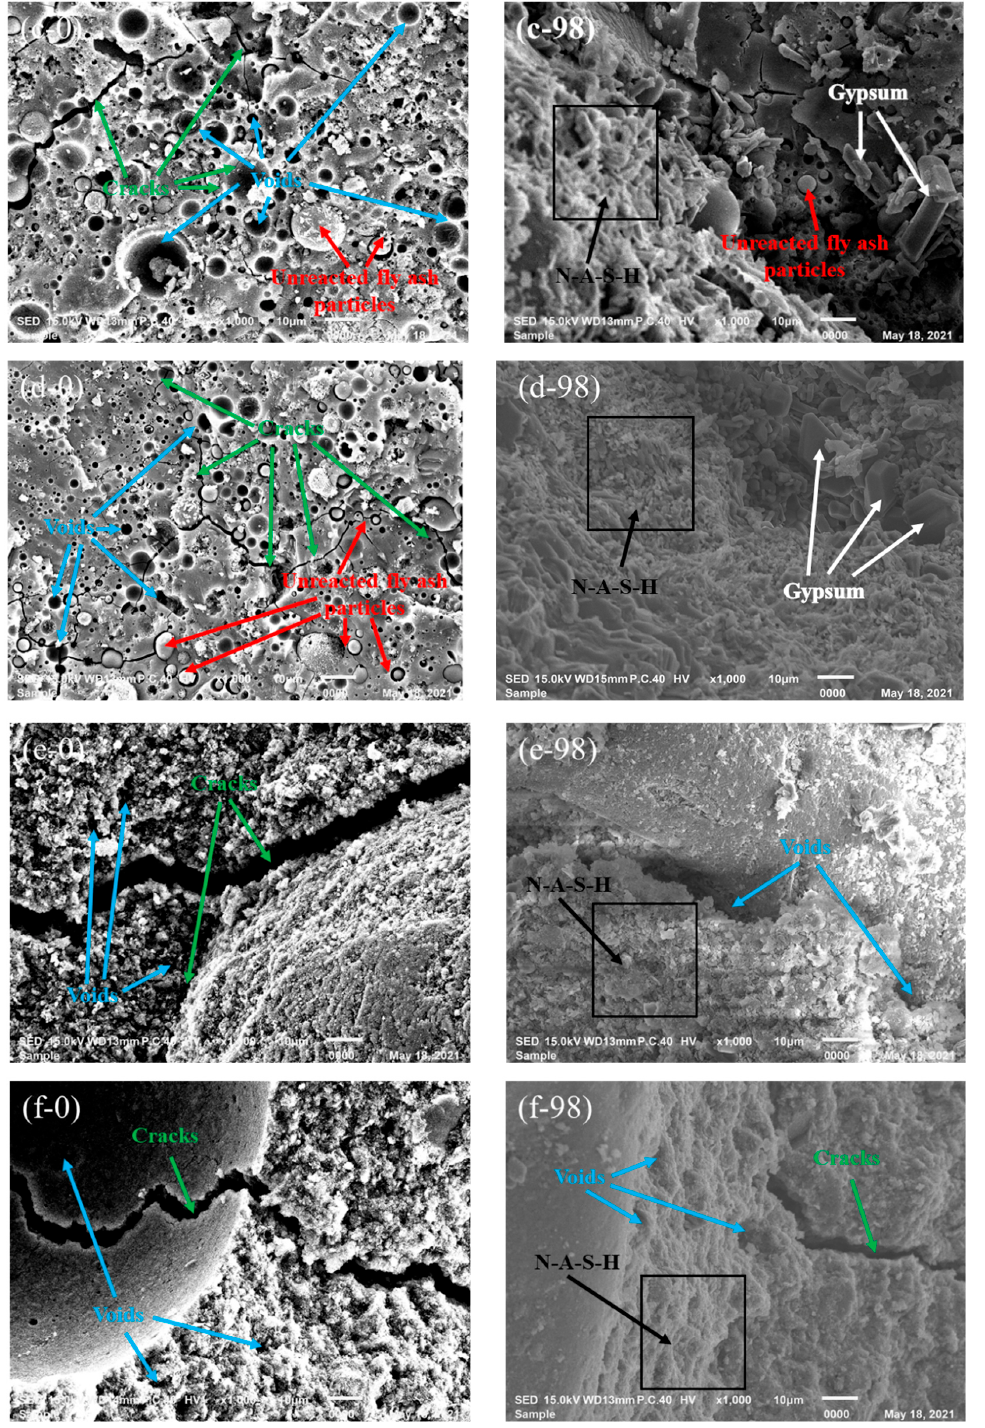
Figure 7. SEM images of GPC exposed to sulfuric acid solution for 0 ( left ) and 98 ( right ) days: ( a ) C-8; ( b ) C-12; ( c ) F-8; ( d ) F-12; ( e ) MK-8; ( f ) MK-12.